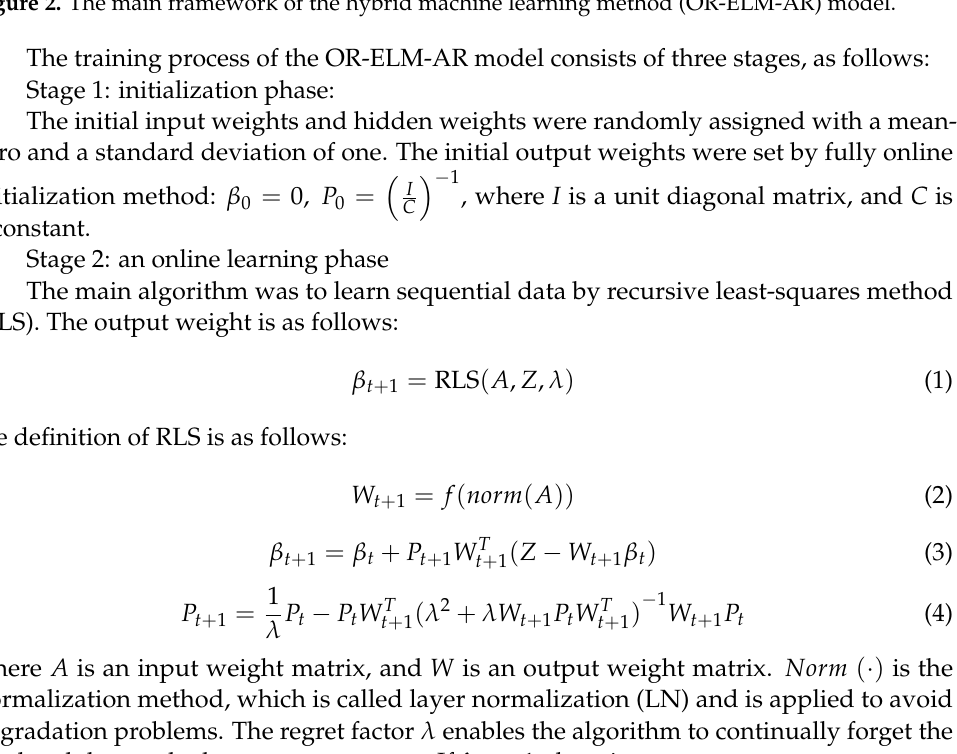
Figure 2. The main framework of the hybrid machine learning method (OR-ELM-AR)